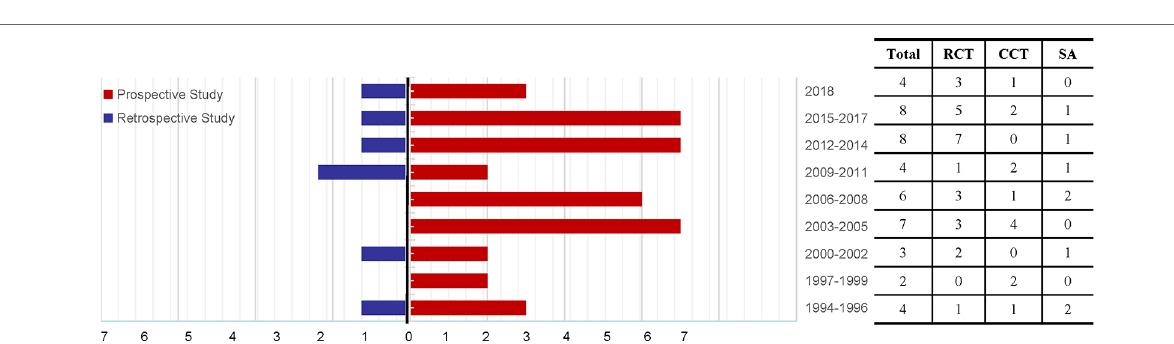
FIGURE 3 | Time trend of the 46 articles relevant to Tripterygium wilfordii tgpolyglycoside-induced adverse events (prospective studies vs. retrospective studies), search performed until November 2018. RCT, randomized controlled trial; CCT, controlled clinical trial; SA, single-arm